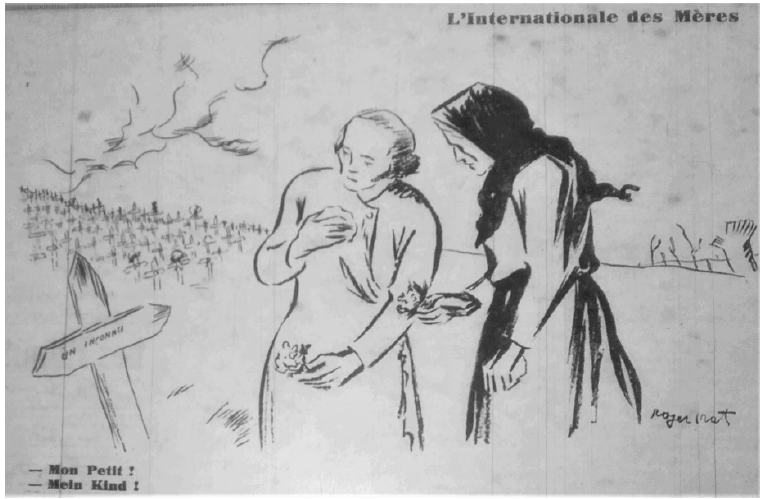
Figure 6. Roger Irat. “Mother’s International. My child! My child!” La Patrie Humaine. 16–23 April 1932. Ink on Paper. Bibliothèque Nationale de France.